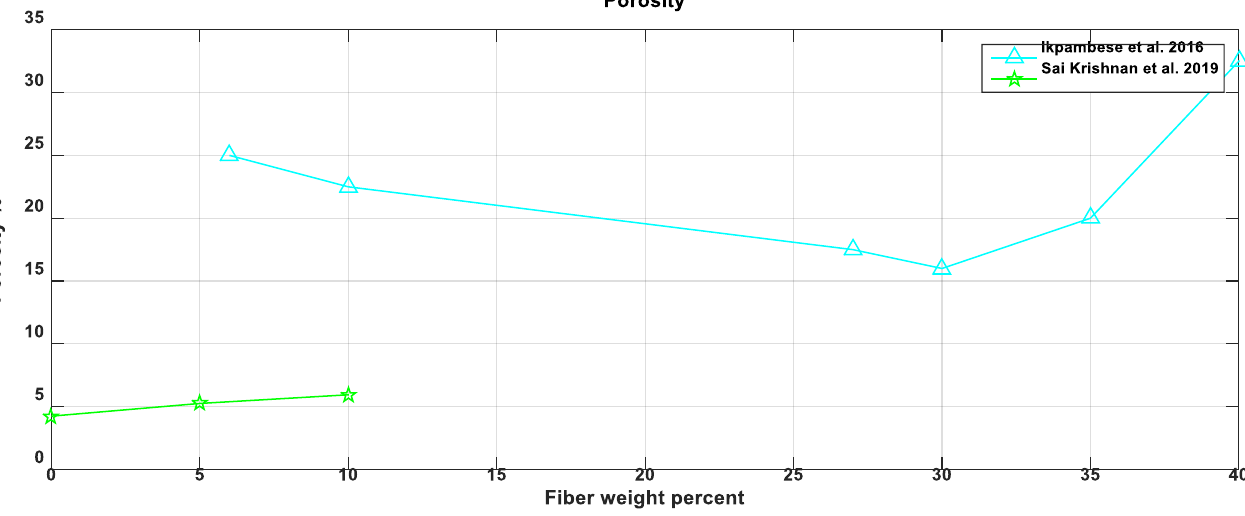
Figure 4. The porosity percentage variation with variation of fiber weight percentage for different fibers [56,67].